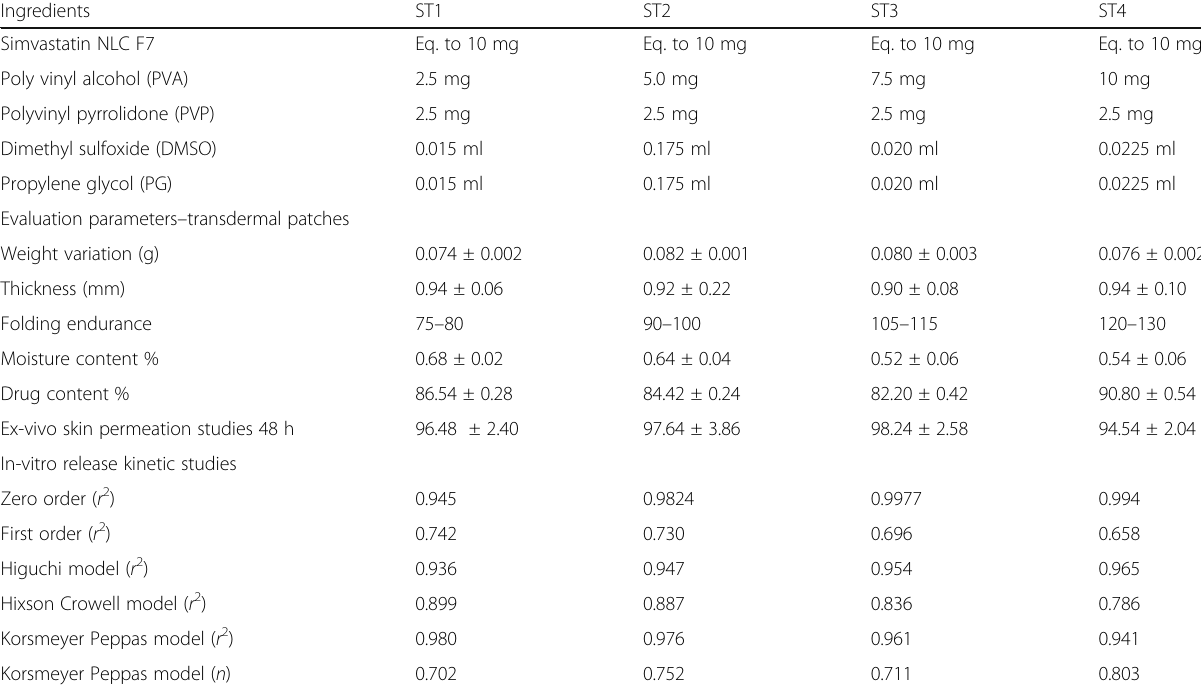
Table 3 Formulation and evaluation of simvastatin NLC loaded transdermal patches (mean ± SD, n = 3)